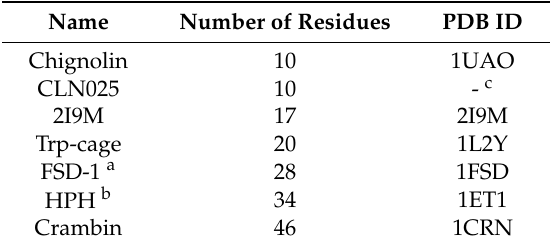
Table 1. Proteins used in this